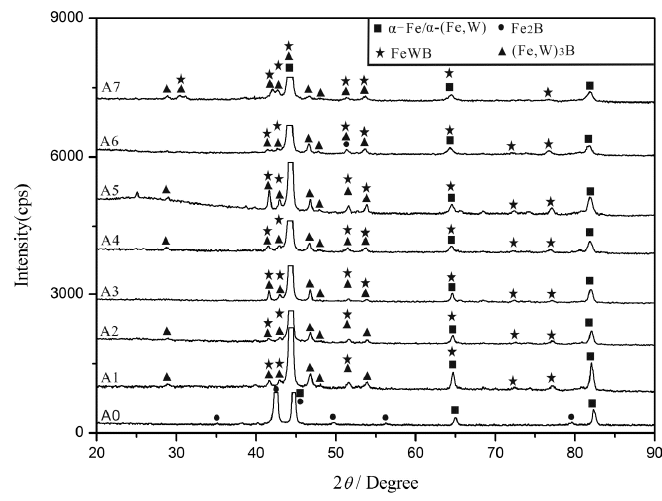
Figure 3. X-ray diffraction patterns of Fe-3.5B alloys containing different amounts of tungsten.